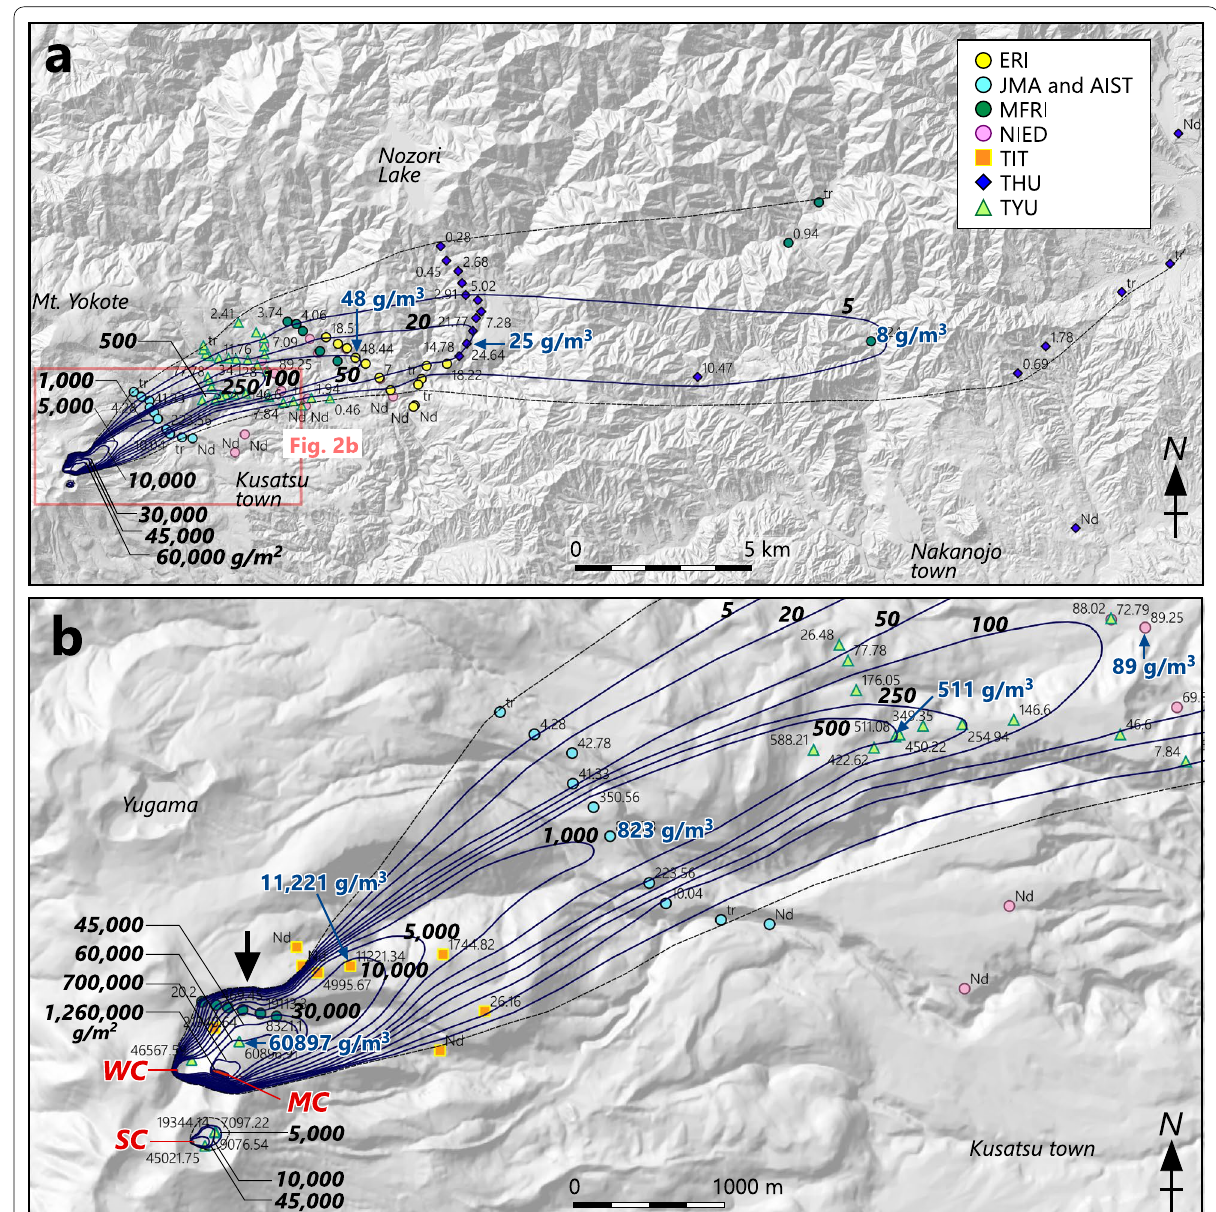
Fig. 2 Isomass contour map of the 2018 eruption of Kusatsu-Shirane Volcano. a Distal area. b Proximal area and part of the distal area. Dashed lines indicate the limit of the distribution of the fall deposits. The dark blue text indicates the MPUA values along the dispersal axis. tr trace, nd